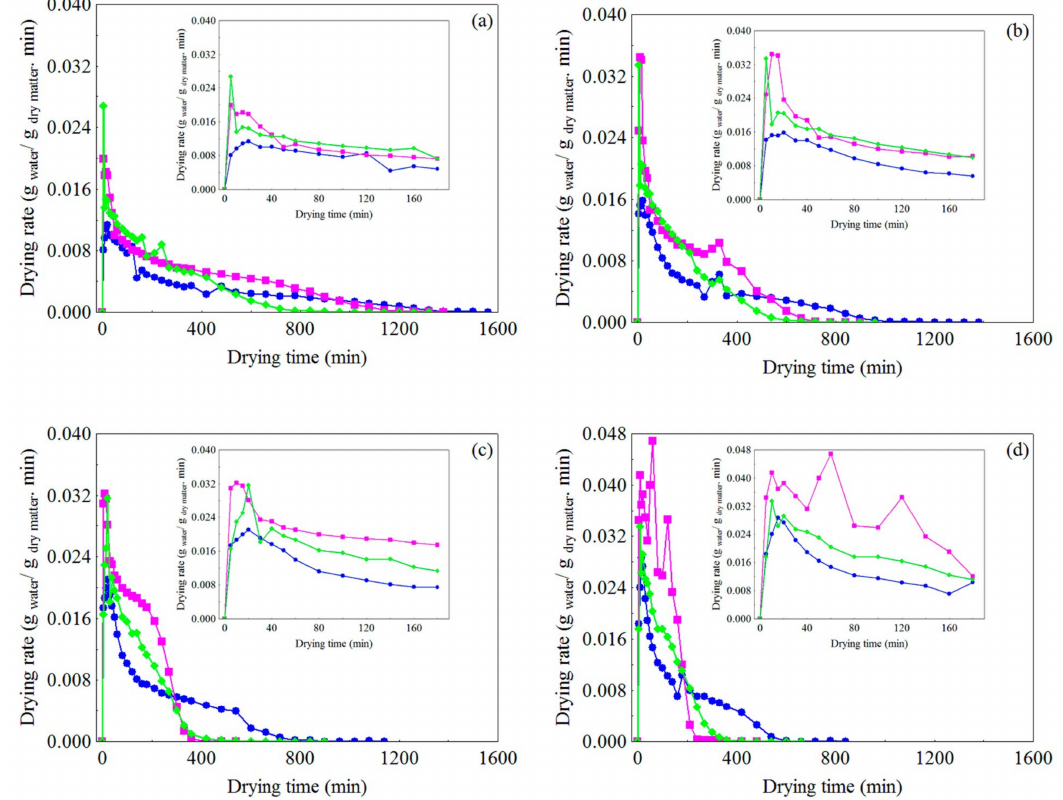
Figure 4. Variation of drying rate vs. drying time in different pretreatments for air temperatures of ( a ) 50 ◦ C, ( b ) 60 ◦ C, ( c ) 70 ◦ C and ( d ) 80 ◦ C: ( ) whole residue, ( ) crushed residue ( ) residue in the form of